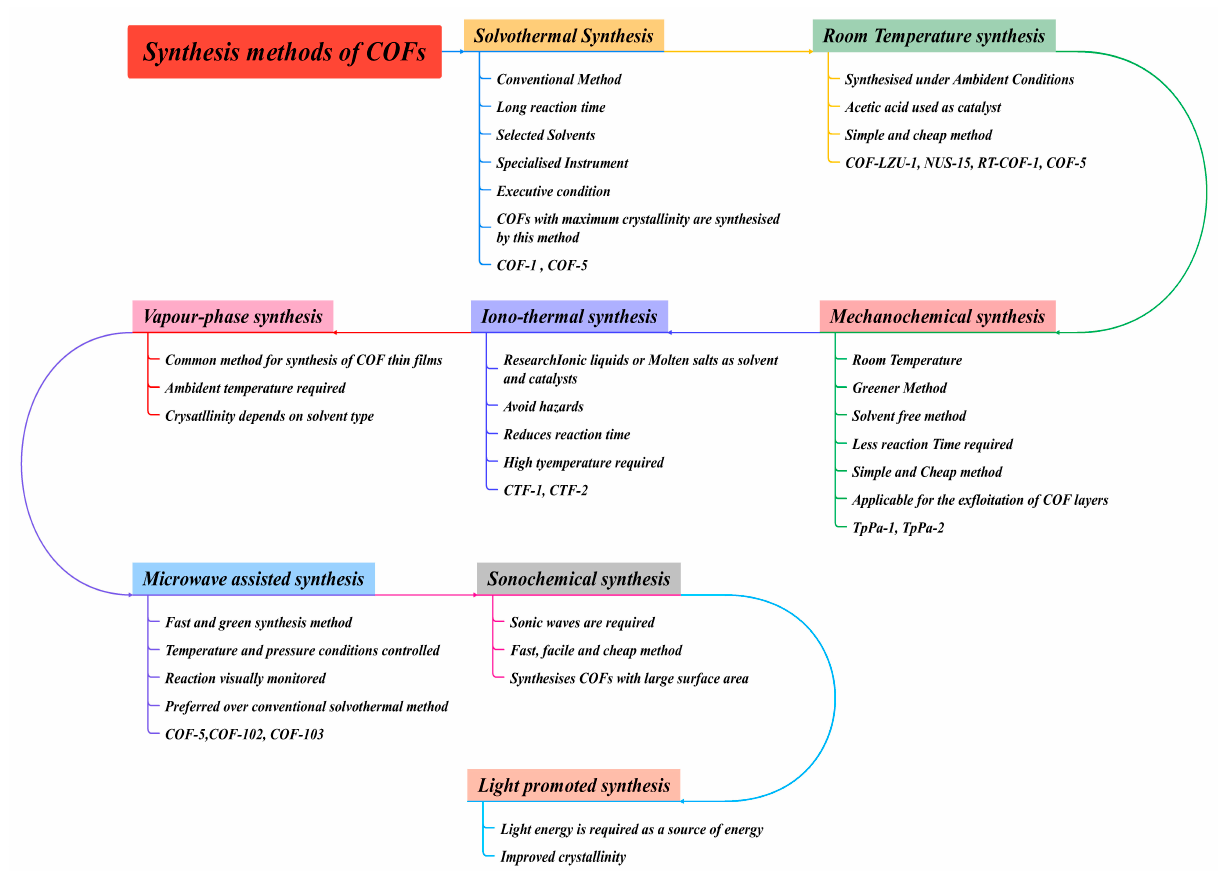
Figure 8. Different synthetic routes for COFs synthesis as per the available literature.